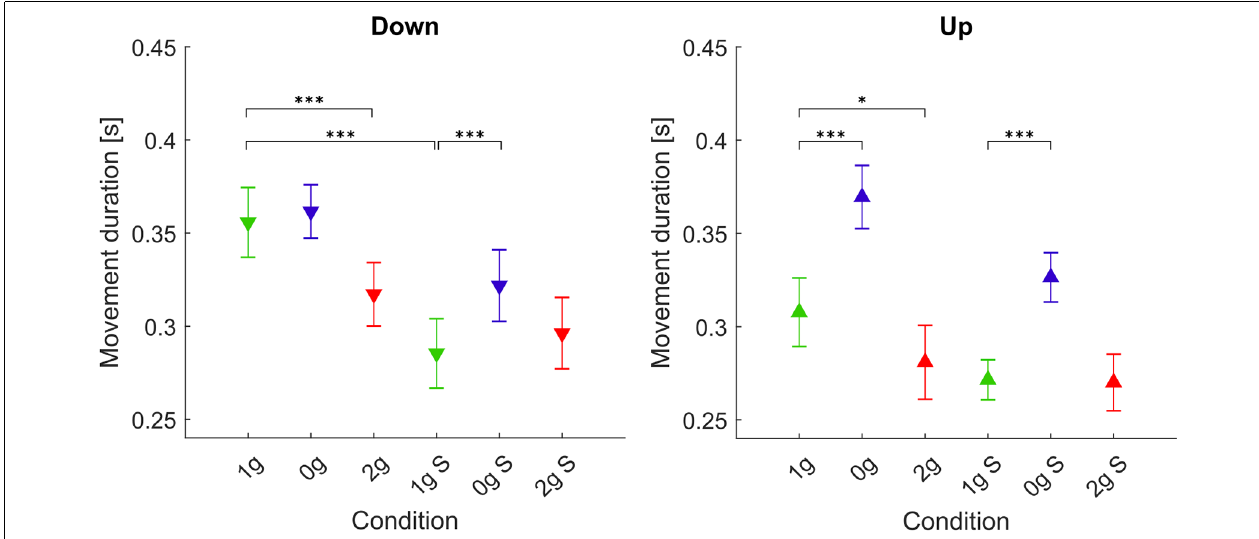
FIGURE 3 | Movement durations in different gravitational and simulation conditions. Downward-pointing triangles denote mean values for downward movements, upward-pointing triangles denote mean values for upward movements, the whiskers denote the standard error of the mean. Green represents normogravity, blue represents microgravity and red represents hypergravity conditions, (1g, 0g, 2g) denote in-flight gravitational conditions, (1g S, 0g S, 2g S) denote simulated gravitational conditions. ∗ p < 0.05, ∗∗∗ p < 0.001.